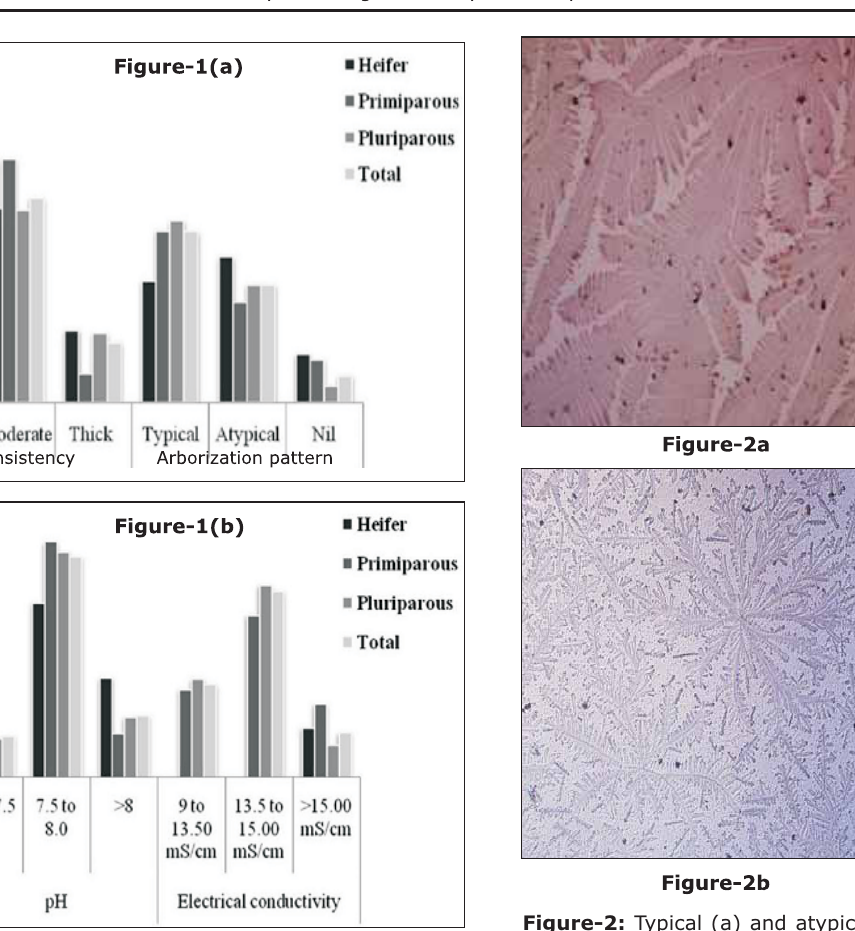
Figure-1 (a & b): Physico-chemical chemical properties of cervical mucus in Murrah buffaloes (n=94) at the time of AI.